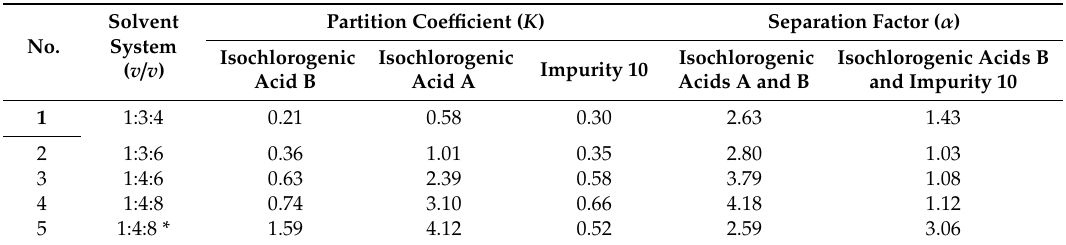
Table 1. Partition coefficients ( K ) values of isochlorogenic acids A and B and the major nontarget